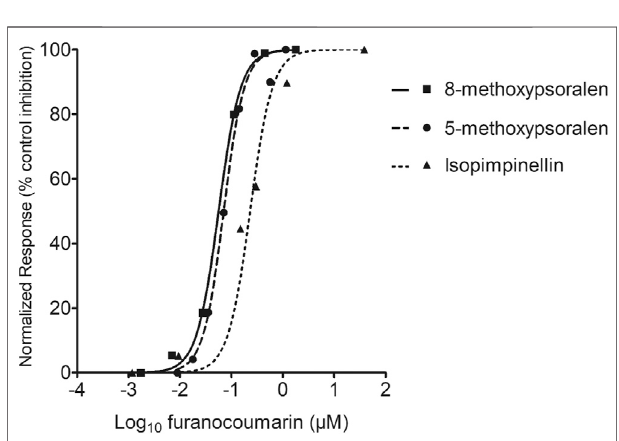
FIGURE 5 | Effects of furanocoumarin concentration on CYP 1A2 inactivation in vitro . The results are presented as the mean of at least three incubations.The ± SDofthedataisomittedforbetterdisplayandcomparison. The IC 50 was determined from the concentration-inhibition curve using non-linear regression analysis.